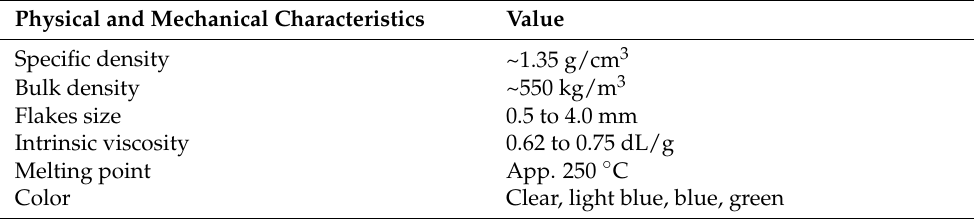
Table 1. Physical and mechanical characteristics of washed PET fines.